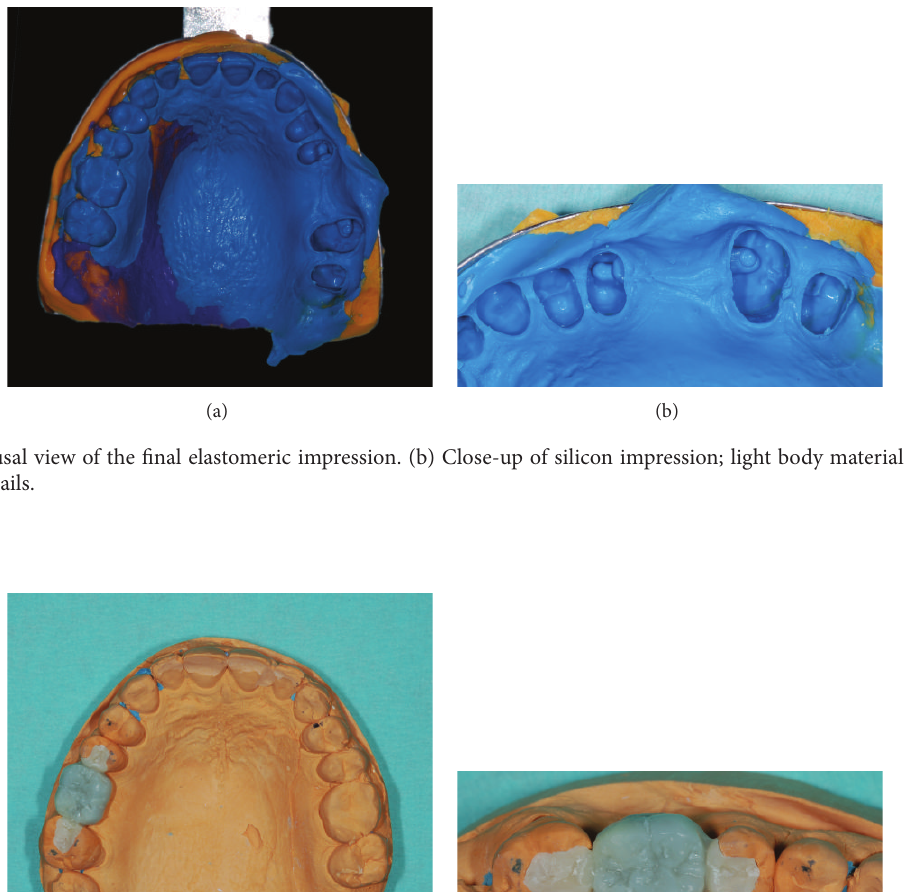
Tokyo, Japan) which demonstrated no friction and marginal integrity (Figure